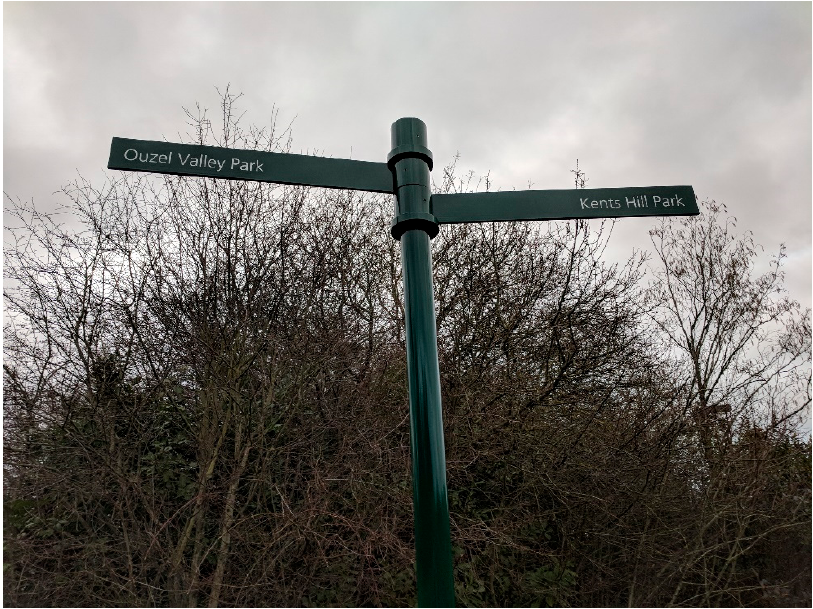
Figure 10. A signpost on a Redway, pointing to the Kent’s Hill district or Ouzel Valley Park. Permission granted by Marston.